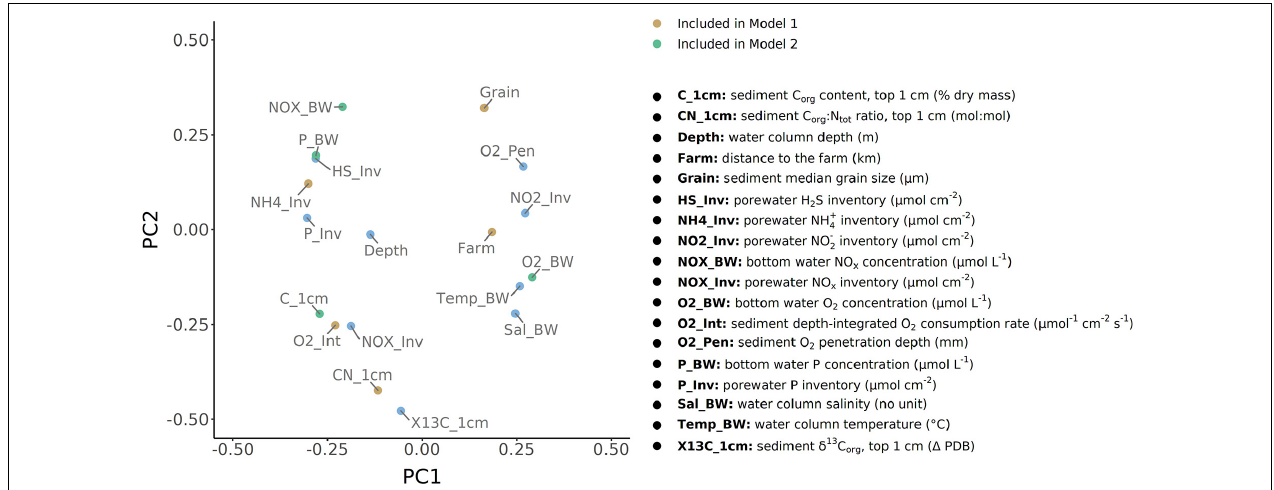
FIGURE 2 | Principal component analysis showing linear dependencies between a total of 18 sediment, sediment porewater, and water column variables (centered and scaled data). The data correspond to measurements determined for a total of six field sampling sites in the Archipelago Sea (Baltic Sea, Finland).